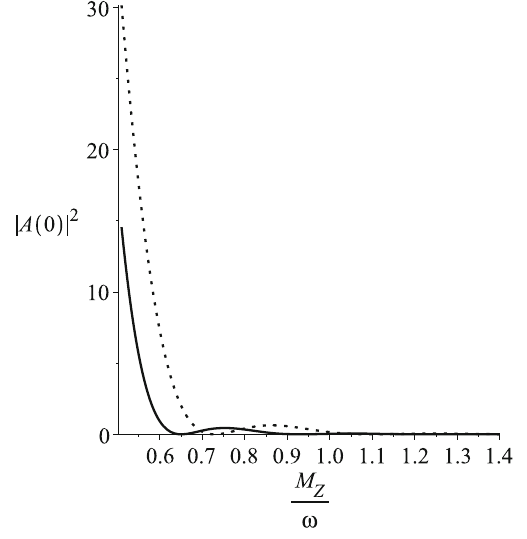
Fig. 8 | A ( 0 ) | 2 as a function of parameter M Z /ω . Solid line is for p = 0 . 5 , p (cid:11) = 0 . 4 , P = 0 . 0001, while the point line is for p = 0 . 4 , p (cid:11) = 0 . 2 , P = 0 .